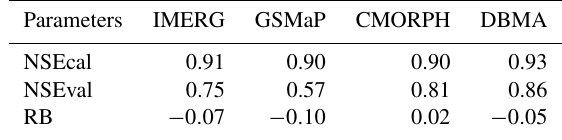
Table 5. Evaluation metrics of hydrological simulations forced by IMERG, GSMaP, CMORPH and